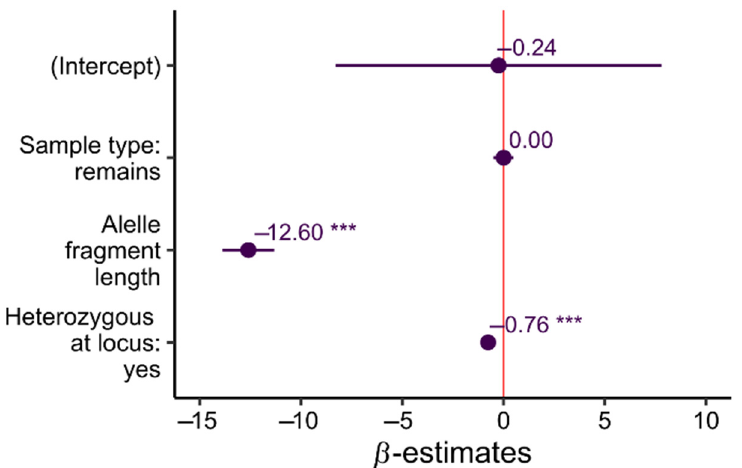
Figure 4. Estimated regression coefficients ( β ) from the different fixed effects, including the intercept, for linear mixed-effect model. Error bars represent the corresponding 95% confidence intervals. Variables were standardised before analysis to enable direct comparison of coefficients. *** p < 0.001.